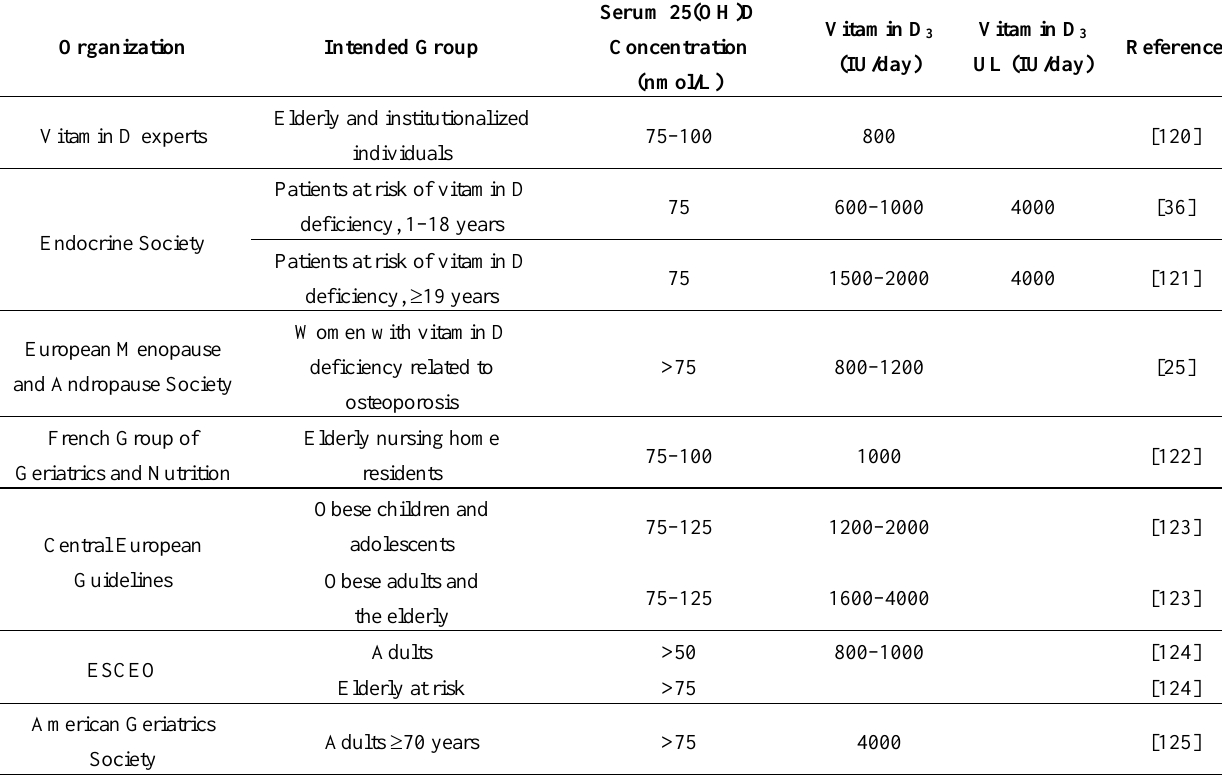
Table 6. Vitamin D recommendations by organizations and